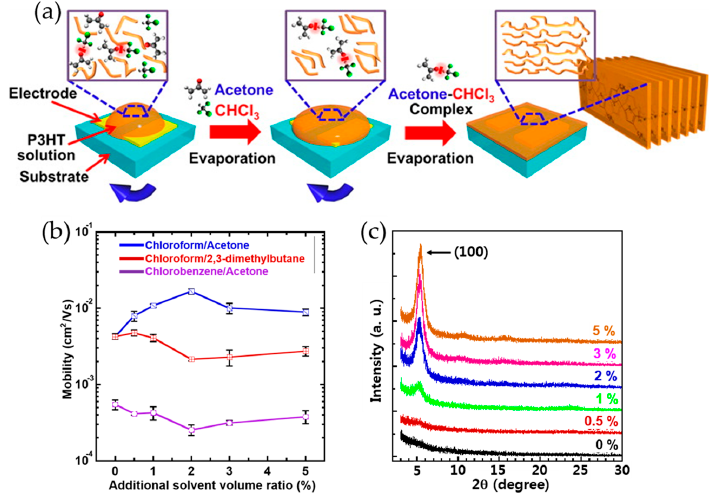
Figure 1. ( a ) Schematic illustration of evolution of molecular ordering of poly(3-hexylthiophene) (P3HT) chains during the deposition process; ( b ) average field-effect mobilities of P3HT films obtained via spin coating from chloroform/acetone, chlroform/2,3-dimethylbutane and chlorobenzene/acetone solvent blends as a function of poor solvent volume ratio; and ( c ) grazing incidence X-ray diffraction profiles of the P3HT films spin-coated from P3HT/chloroform